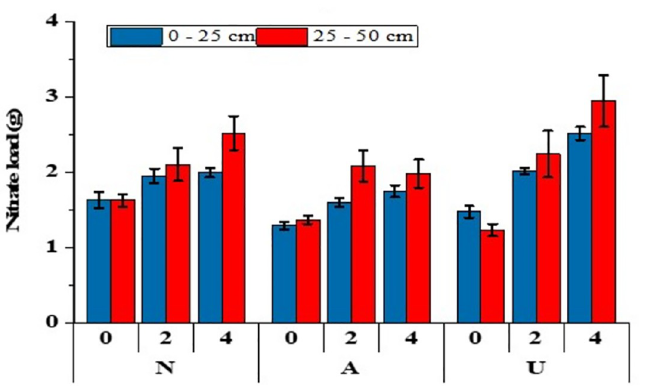
Fig 4. Residual nitrate loads (g) in soil after leaching events (days) at 0%, 2% and 4% bentonite with Ca(NO 3 ) 2 (N), NH 4 Cl (A), and CO(NH 2 ) 2 (U). � , �� and ��� show significant difference at P < 0.05, P < 0,01 and P < 0.001, respectively.